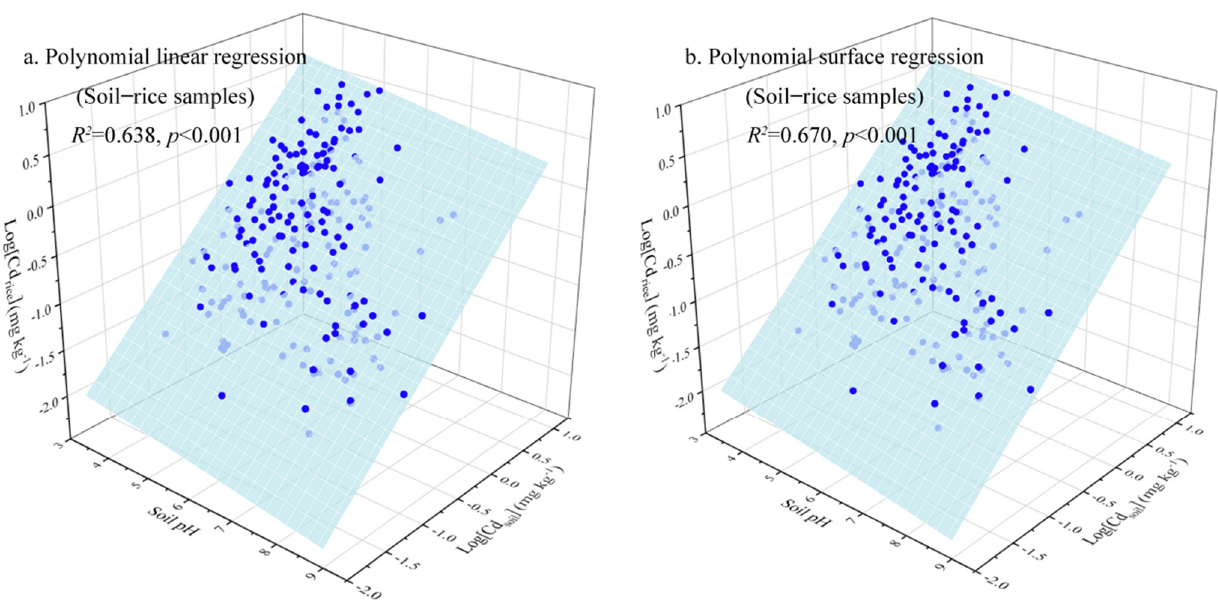
Figure 4. Relationships between Cd uptake by rice grains, soil Cd concentrations, and soil pH.